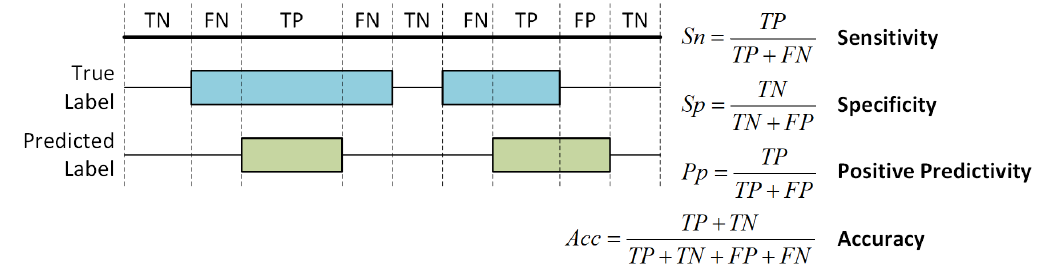
Figure 7. Performance measures using sensitivity, specificity, positive predictivity, and accuracy.